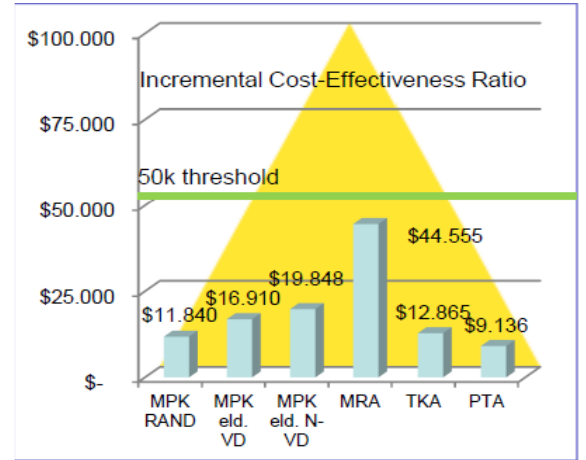
Figure 1. Comparison of ICER findings for elderly with RAND